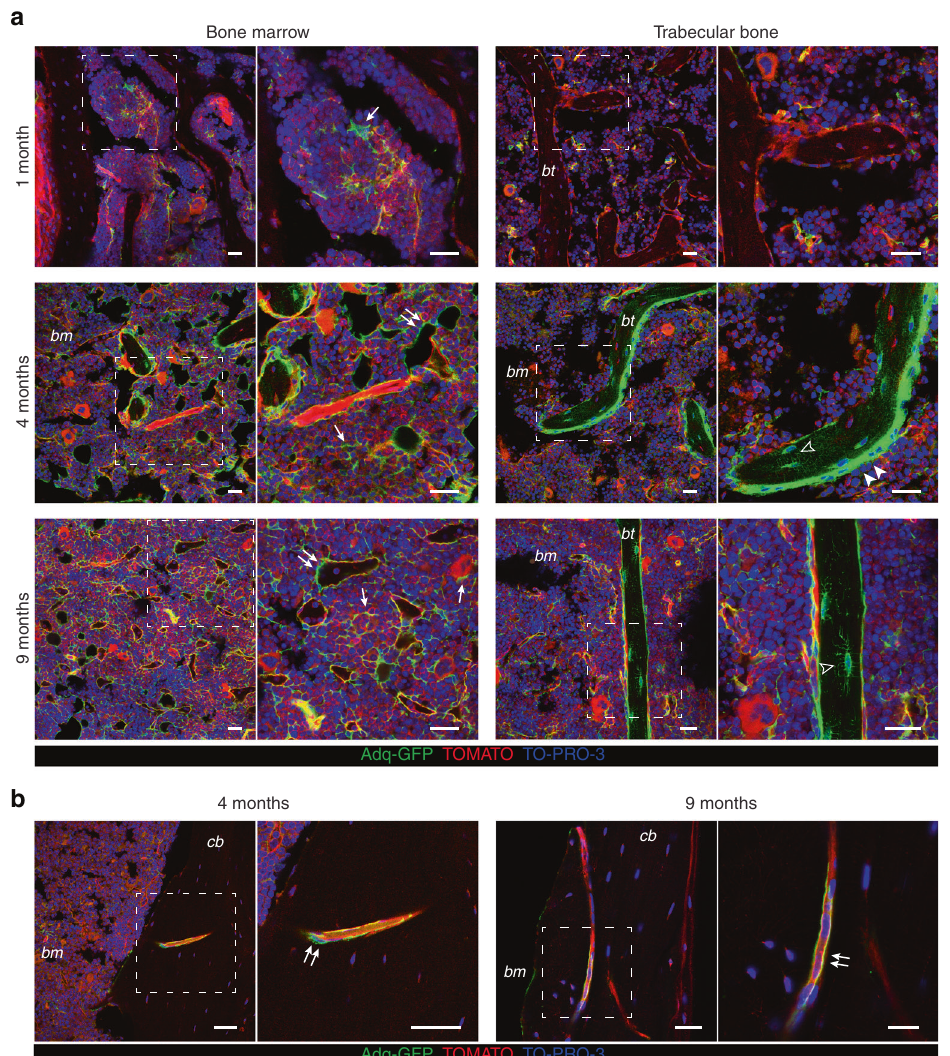
Fig. 1 Adipoq-Cre -targeted cell population in bone marrow and bone. a Representative confocal images of bone marrow and trabecular bone from 1-, 4- and 9-month-old Adq-mTmG mice. GFP labeling was restricted to a small number of stromal cells at 1 month of age ( arrow ), while at 4 and 9 months it highlighted numerous marrow stromal ( arrow ) and perivascular ( double arrow ) cells, the majority of osteoblasts ( arrowhead ) and osteocytes ( hollow arrowhead ). b Representative fl uorescent images of GFP-labelled intracortical perivascular cells ( double arrow ) in 4- and 9-month-old mice. bm Bone marrow, bt Bone trabecula, cb Cortical bone. Scale bars 25 μ (Fig. S4a), and its surfaces were covered by numerous TRAP positive osteoclasts (Fig. S4b). In these samples, the marrow spaces contained focal clusters of hematopoietic cells and adipocytes and were largely fi lled with ALP positive stromal cells (Fig. 4f). Confocal analysis demonstrated GFP-expressing osteo- blasts and osteocytes in control transplants (Fig. 4h), thus supporting the existence of an Adq -stromal cell population in mouse long bone that is inherently osteogenic. In parallel with the higher amount of bone, GFP-labeled cells were numerous in Adq- mTmG;Gs α R201C transplants in which GFP expression was also found within the ALP positive marrow stroma (Fig. 4i).